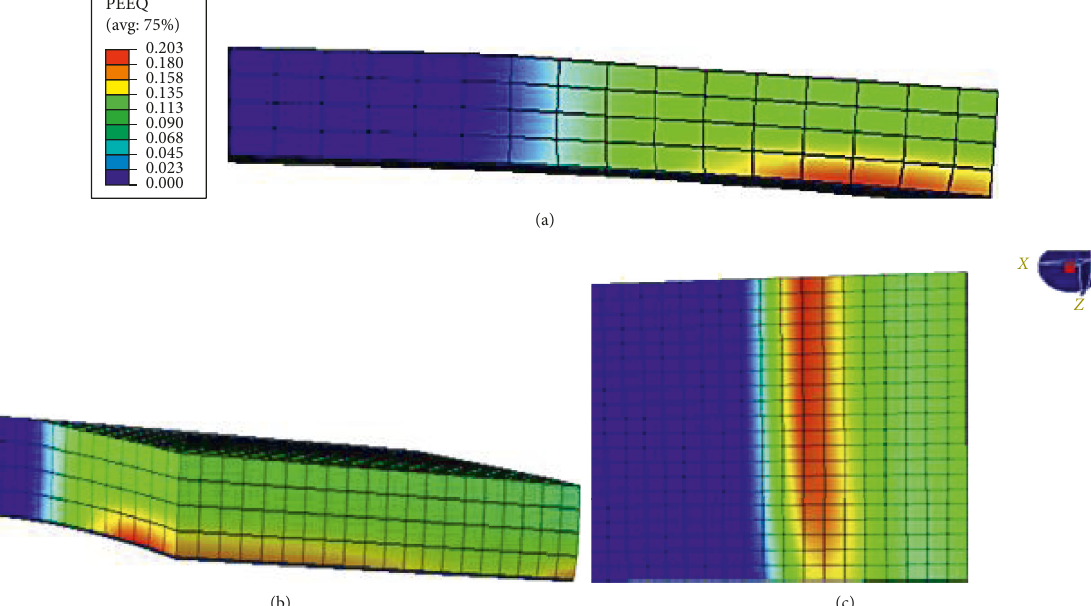
Figure 10: The distribution of equivalent deformations in the thermal deformation hearth (a, b) and in the zone of tape contact with the surface of the part (c) in the case of electrocontact surfacing with a steel tape at K v 0.04 sec. t imp (cid:31)